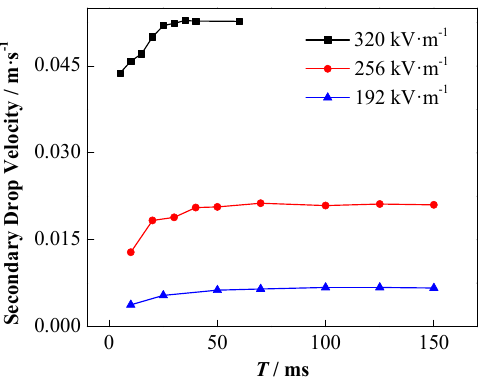
Figure 15. Change in the rising speed of secondary droplets with time under different electric field strength conditions (the particle concentration is 1 wt%).